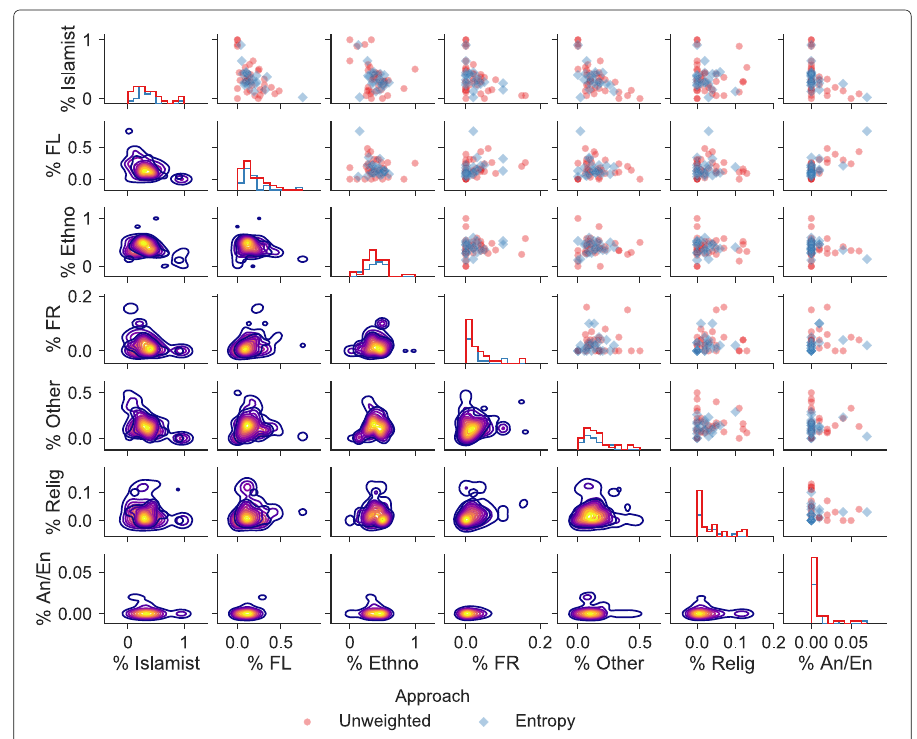
Fig. 6 Kernel Density, Histogram and Scatter Plots of Cluster Distribution for Both Approaches - Ideological Variables. The graphic visualizations demonstrates that more represented or well-defined ideologies tend to have stabler relations across both approaches. Relation for environmental/animalist and religious (Islamist excluded) groups appear to be more